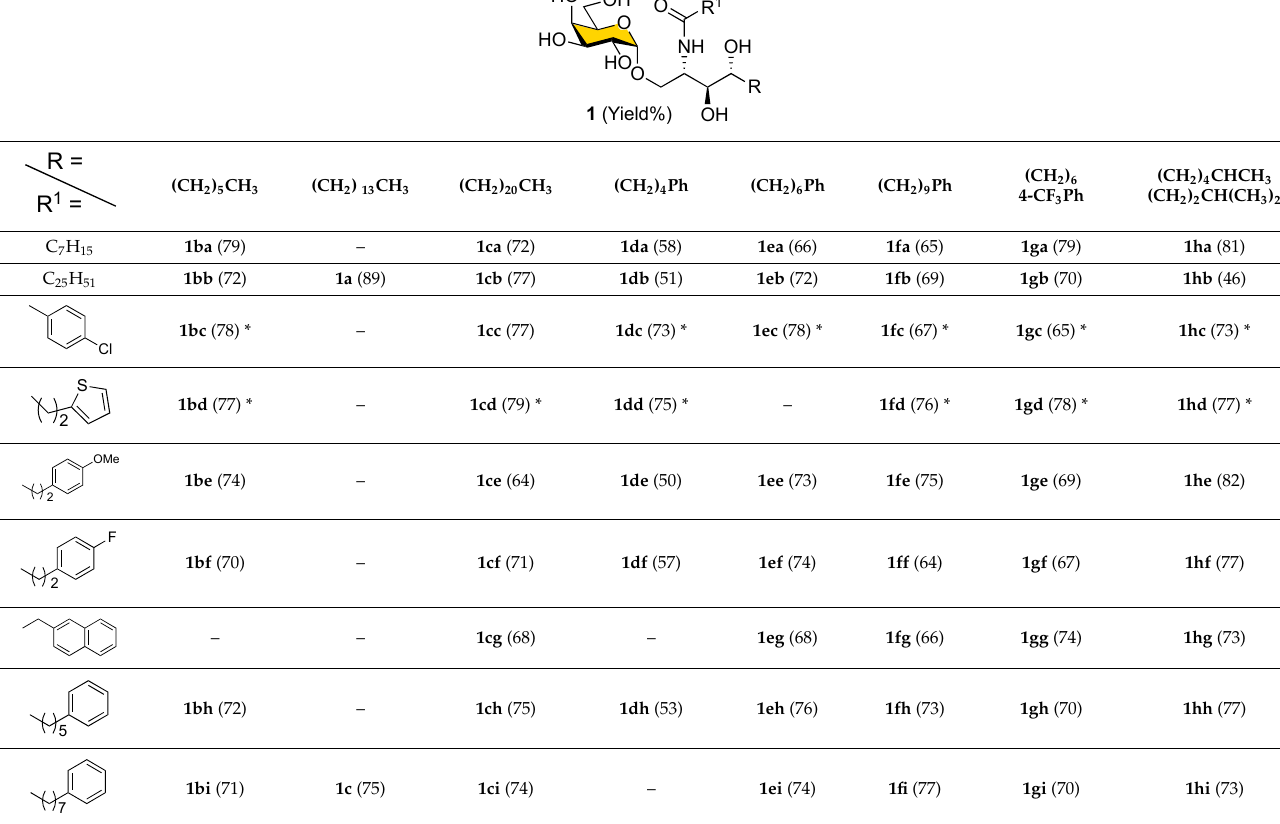
Table 2. The structures and chemical yields of α -GalCer analogs ( 1 ) a .